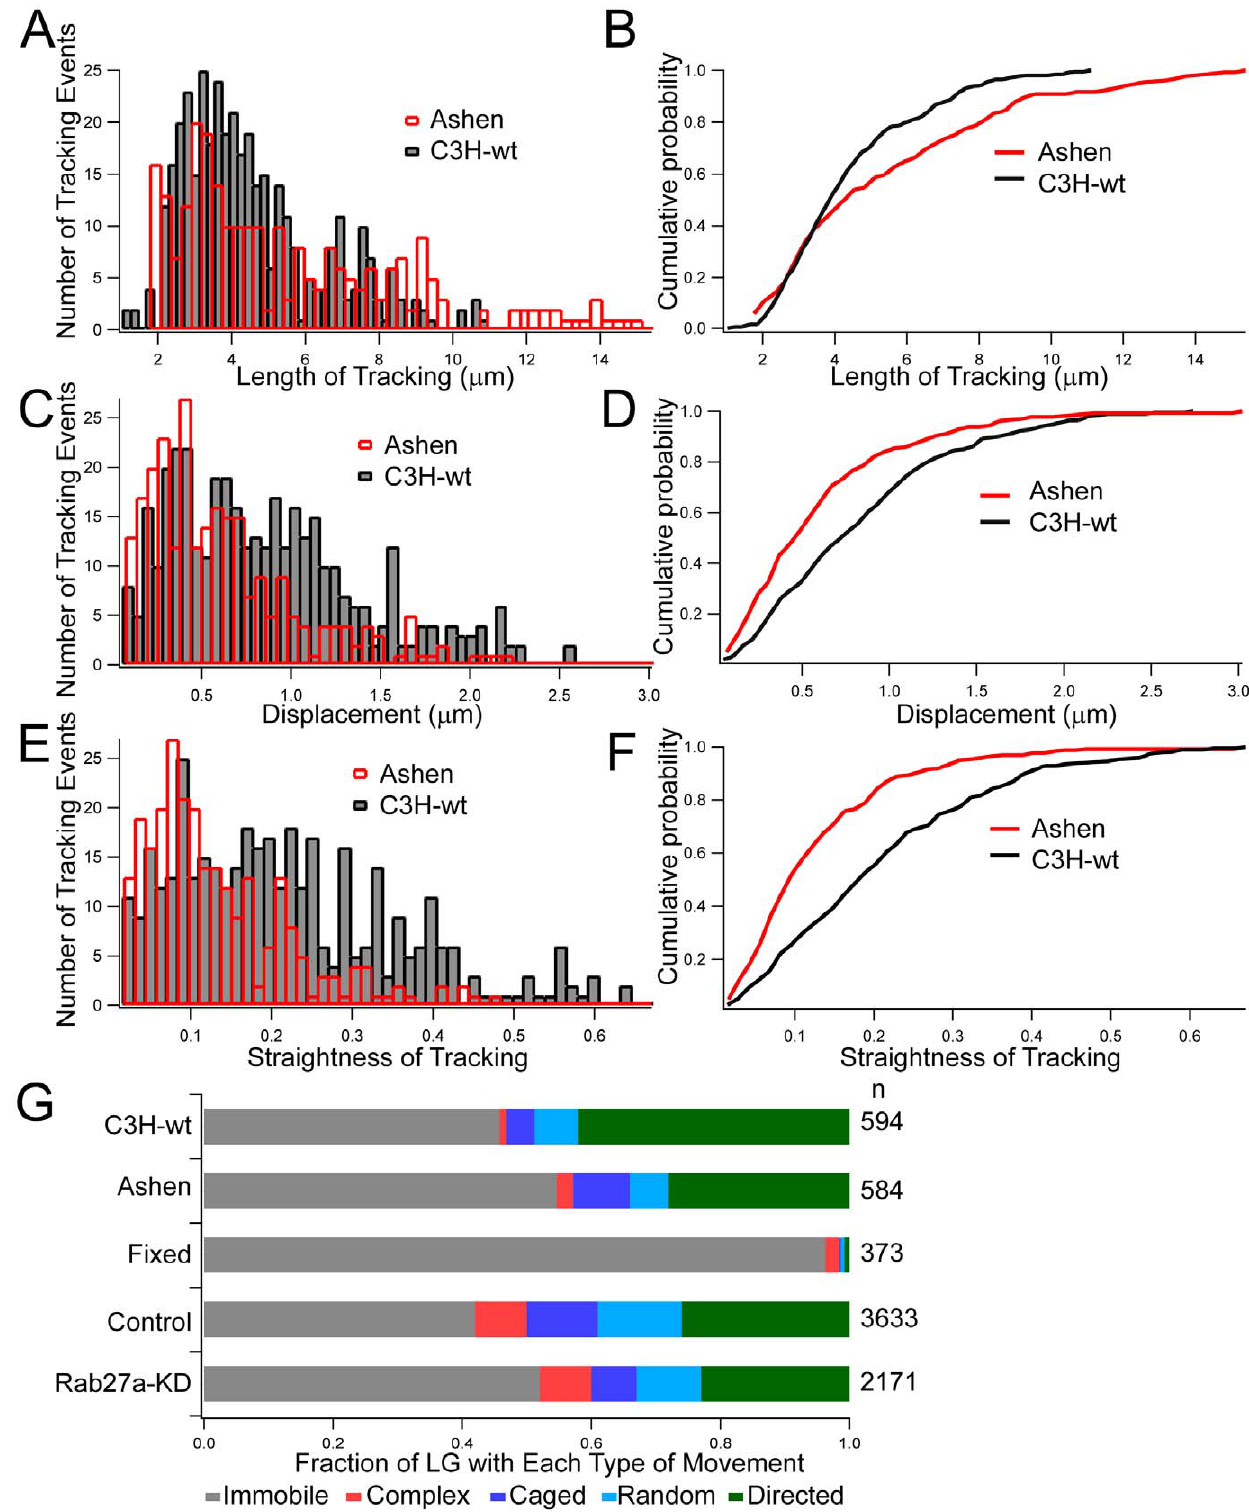
Figure 2. Rab27a mutant decreased straightness and displacement but increased length of LG tracking at the PM. The length (A and B), displacement (C and D), and straightness (E and F) of LG trajectories from Ashen (red) and CH3 mice (black) are compared using histograms and cumulative probability plots. The data is derived from granules that travel within 10 seconds. The relative occurrence of each type of movement for each indicated condition is summarized in a bar plot (G). The numbers of tracking events (n) are listed on the right. The data are representative of at least two independent experiments.